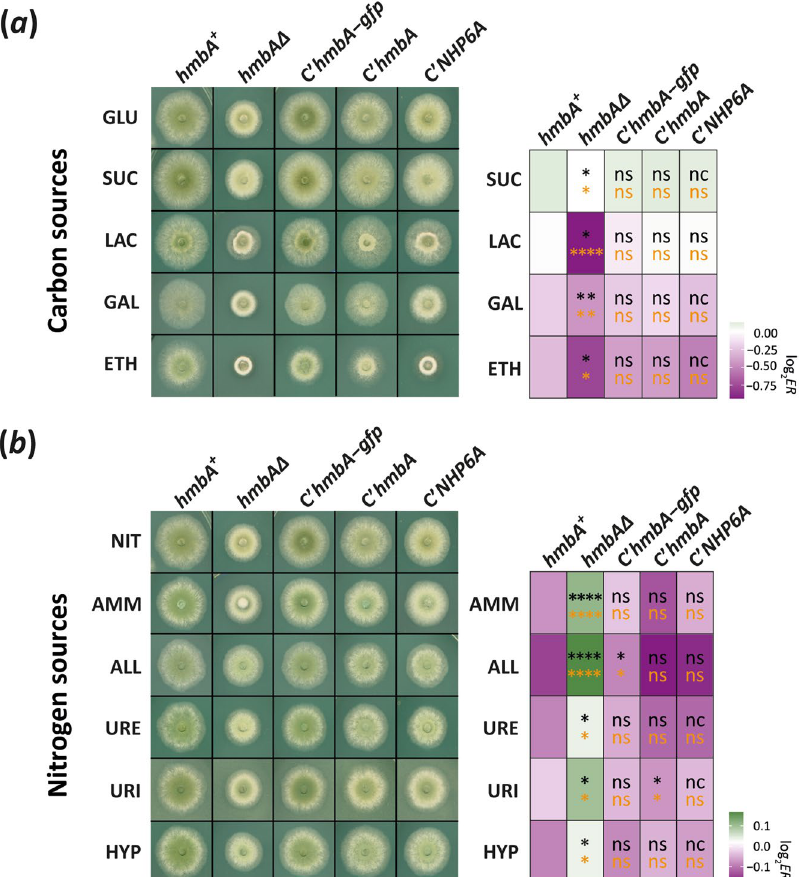
Figure 5. Growth tests and ER values of hmbA + , hmbAΔ and complemented control strains on various carbon- and nitrogen-sources and under various environmental stress conditions. On the right side of each panel, the heatmap shows the log 2 ER values (green and magenta indicates increase and decrease, respectively). Asterisks in the cells show the significance of Student’s t -test (orange) and Mann–Whitney U-test (black) calculated by comparing the ER values of all tested strains to that of the hmbA + control (*/**/***/**** indicates P <